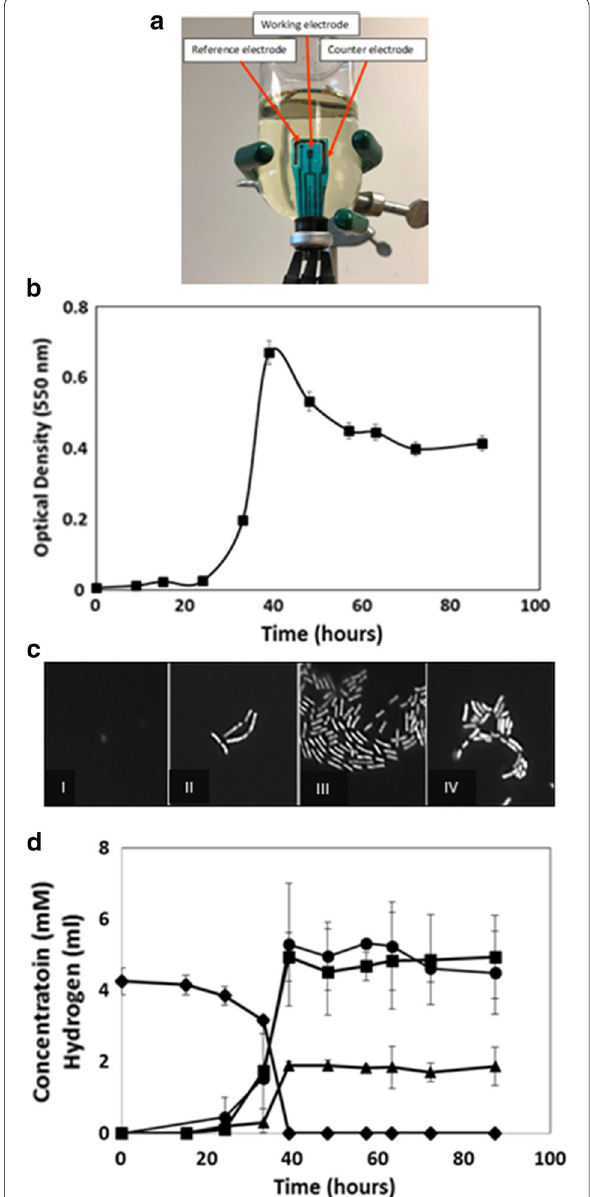
Fig. 1 Experimental arrangement and microbiological data. a Inverted 125 mL serum bottle with electrode assembly inserted through a black butyl stopper and sealed gas tight. Sterile anaerobic growth medium was inoculated with C. phytofermentans spores prior to growth studies. b Growth curve of C. phytofermentans. Concentration of C. phytofermentans is shown over an 87-hour time period. Values are the mean S.D. of two duplicate growth ± studies. c DAPI staining of C. phytofermentans . DAPI stained images at inoculation (I), lag (II), log (III), and stationary (IV) phases of growth. d Conversion of cellobiose (diamond) to acetate (square), ethanol (triangle), and hydrogen (circle) by C. phytofermentans during growth. Values are the mean S.D. of two duplicate growth ±